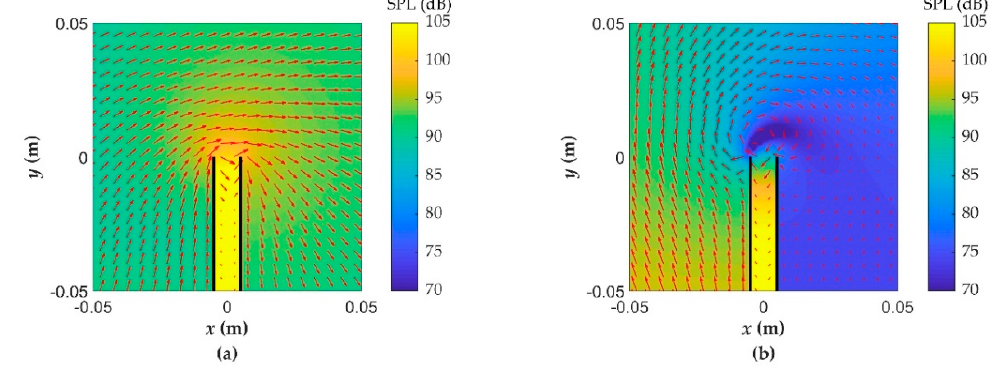
Figure 8. The SPL and sound intensity distribution near the top edge of the barrier at ( a ) 482 Hz, ( b ) 500 Hz.